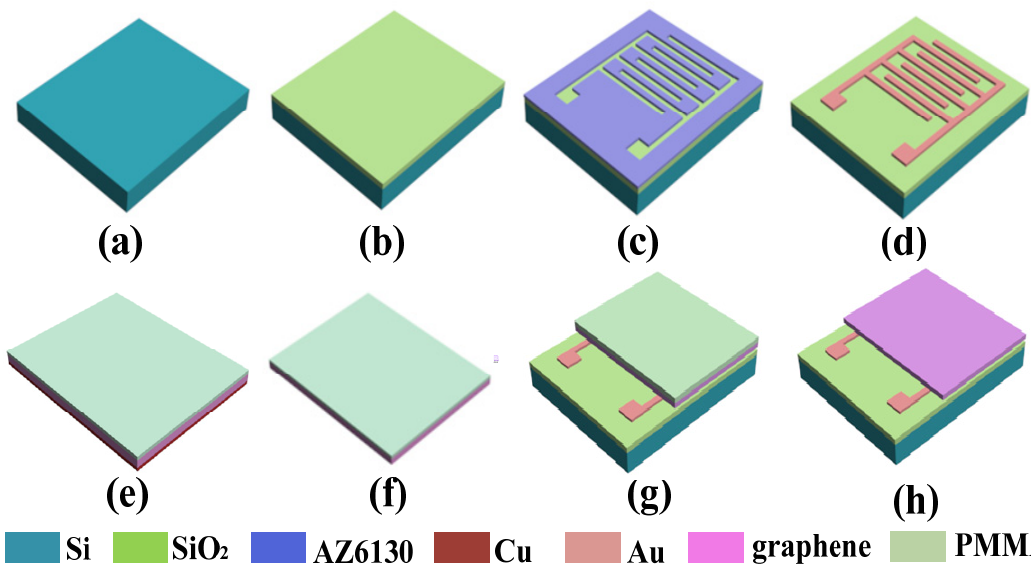
Figure 2. The processing flow of the interdigitated electrode (IDE): ( a ) Prepare the silicon wafer. ( b ) The deposition of SiO 2 insulator layer by the plasma-enhanced chemical vapor deposition (PECVD). ( c ) The IDE structures were patterned by lithography. ( d ) Metal leads deposition (Ti 200 Å/Au 2000 Å) by magnetron sputtering, and the metal layer on AZ6130 photoresist was stripped in acetone by lift-off technology. ( e – h ): Single-layer graphene transferred onto the IDE cell by wet transfer